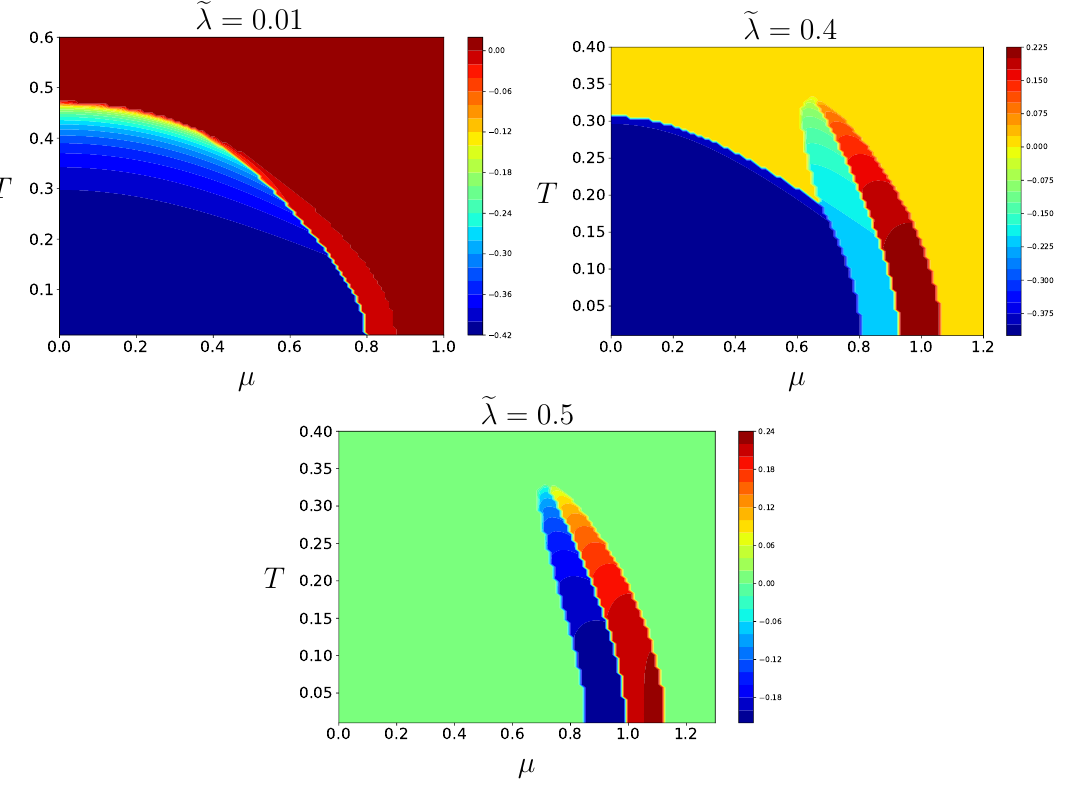
Figure 17 . The M = 3 phase diagram in the large- N limit with g 1 = 1 and g 2 = 3 for various e λ . e e The plotted observable is e 1 − 2 e 2 + e 3 with e 1 ≥ e 2 ≥ e 3 assumed. the right hand side of (6.8)). Whenever µ < µ tri for M = 2 the system experiences a second order phase transition at γ = γ (see eq. (6.5)). Larger values of M remain 2 2